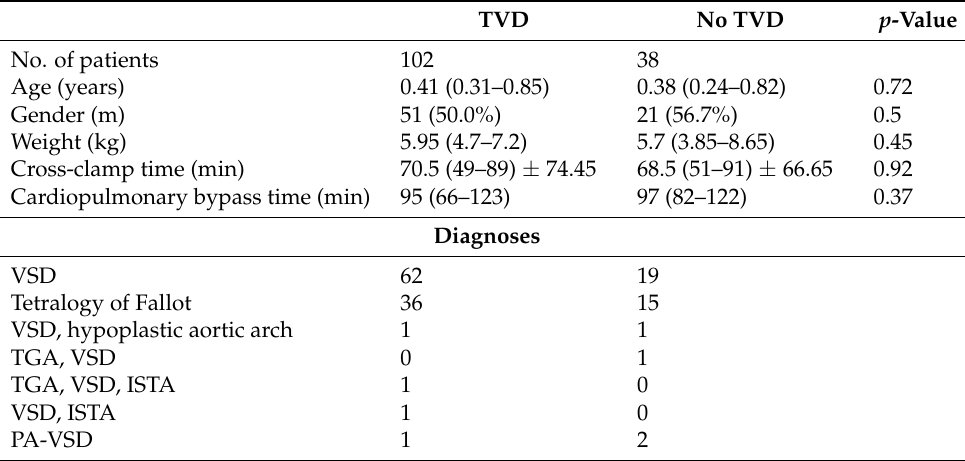
Table 1. Patient description and diagnosis